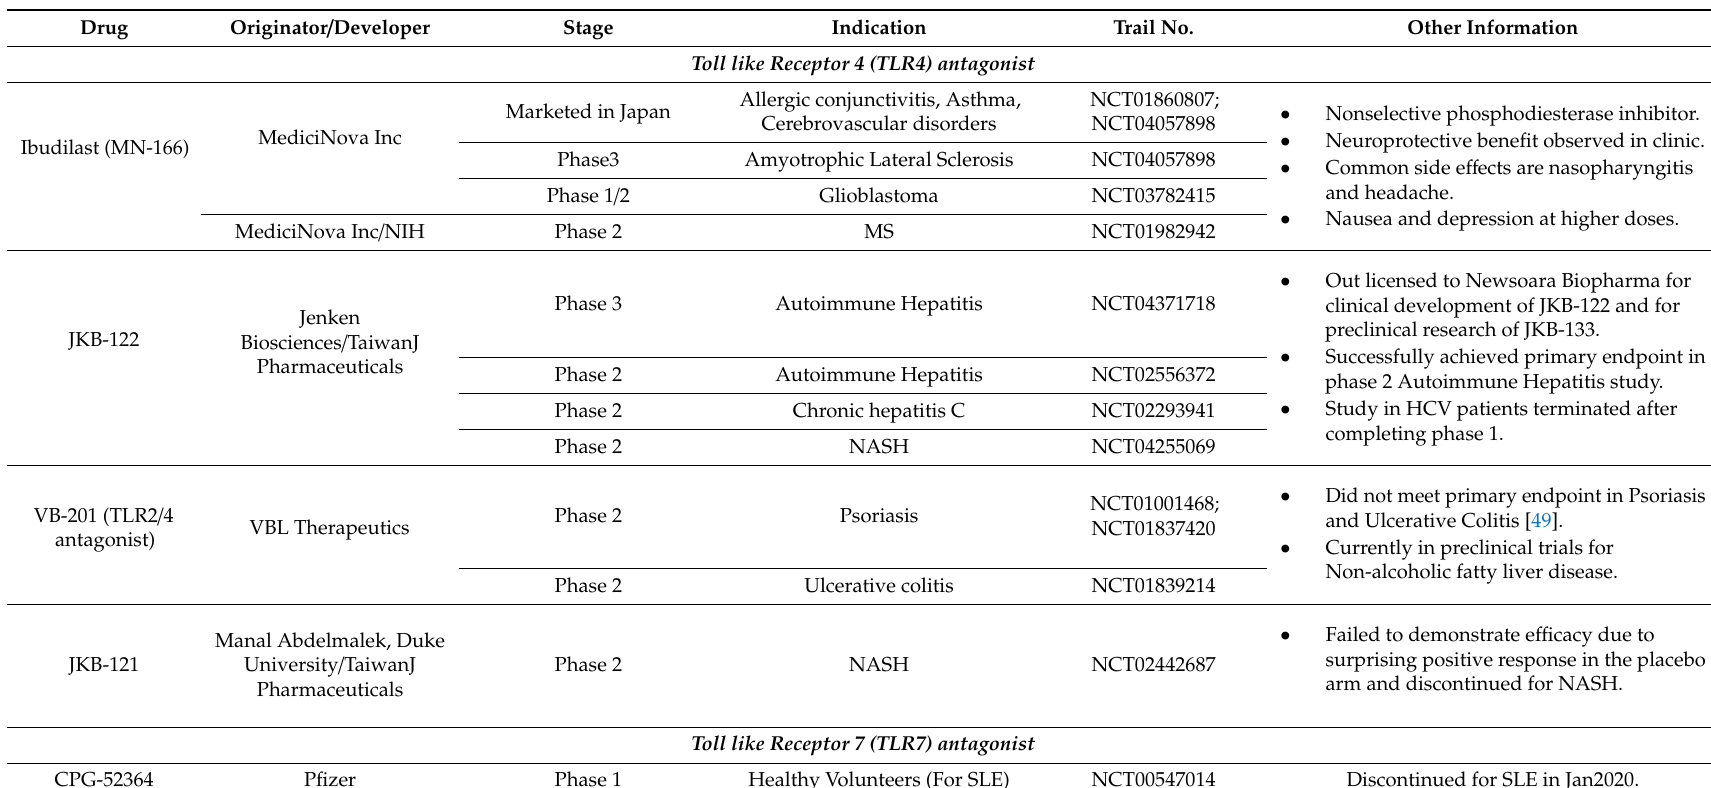
Table 1. Clinical small molecule inhibitors of cell membrane receptors in NF-kB